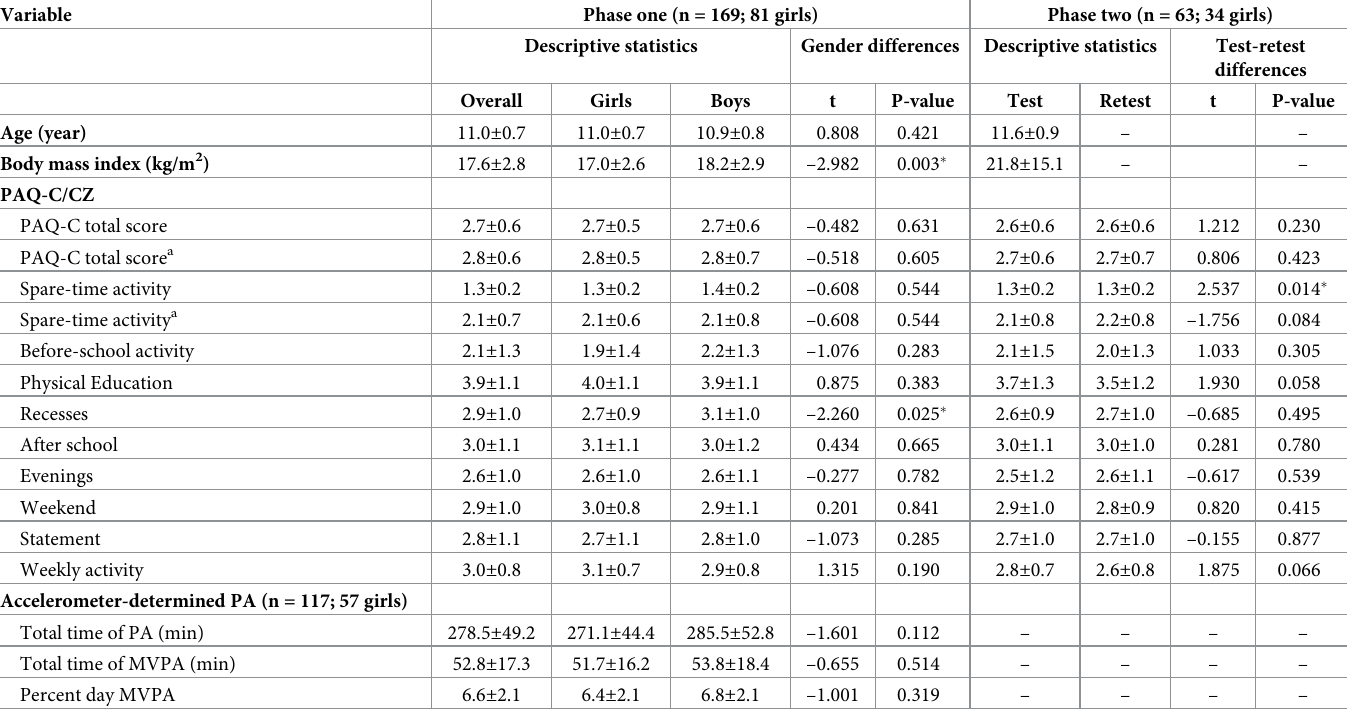
Table 1. Descriptive statistics for the investigated variables in the study (mean ± SD), gender differences (independent sample T-test), and test-retest differences (Student’s paired T-test).